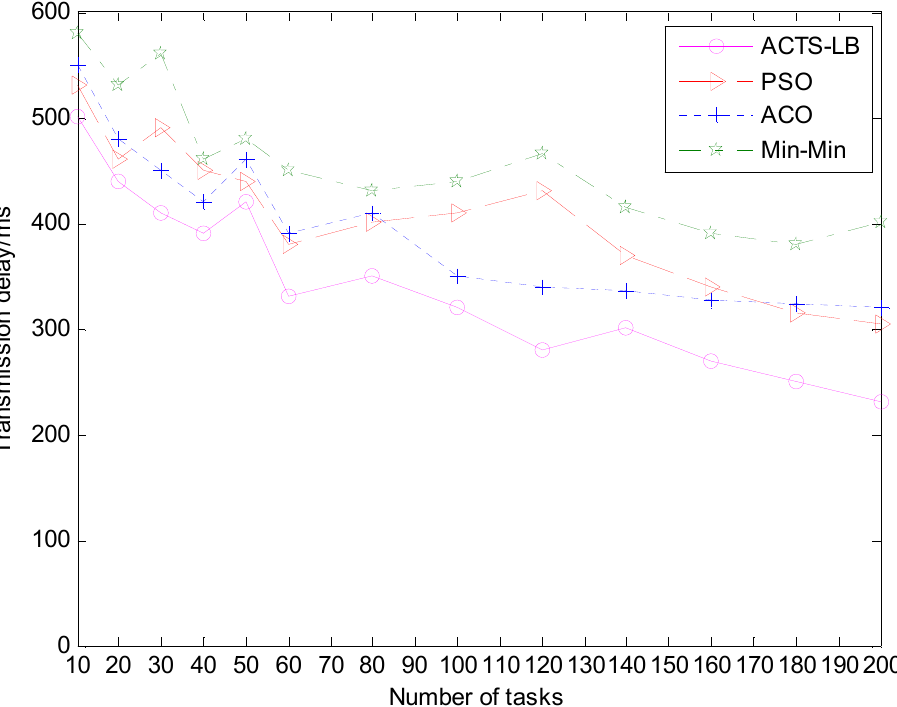
Figure 5. The comparison of transmission delay under different scheduling tasks.